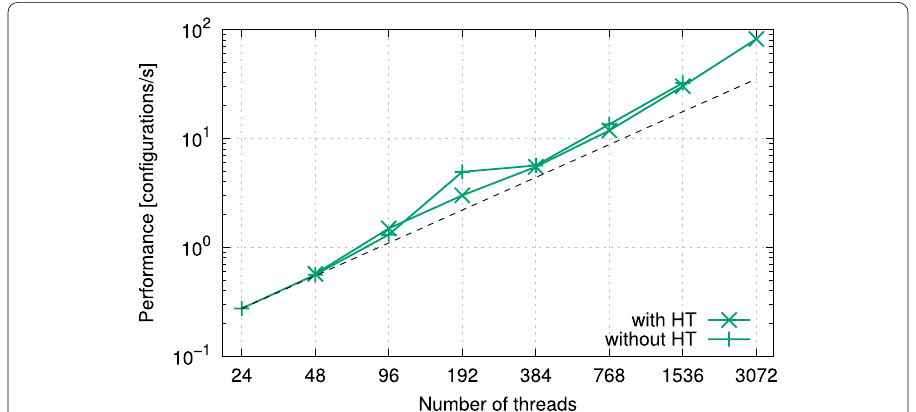
Fig. 8 Performance of the evolution algorithm to search parameters of neural network simulating connectome of C. Elegans . The performance data for execution with and without hyperthreading is presented. The benchmarks were run on Cray XC40 at HLRS. Ideal scaling is drawn with the dashed